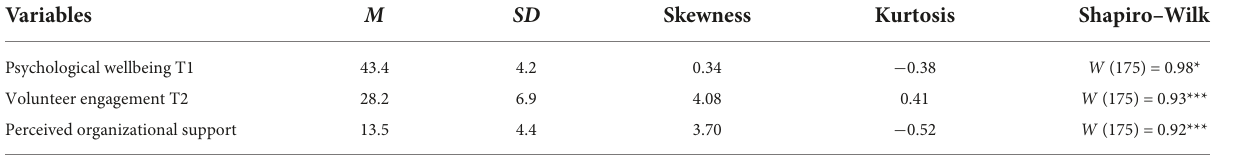
TABLE 4 Means, standard deviations, and normality statistics for winsorized scores. Variables SD